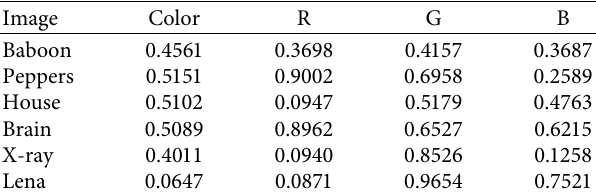
Table 3: Chi-square test measures for different images.